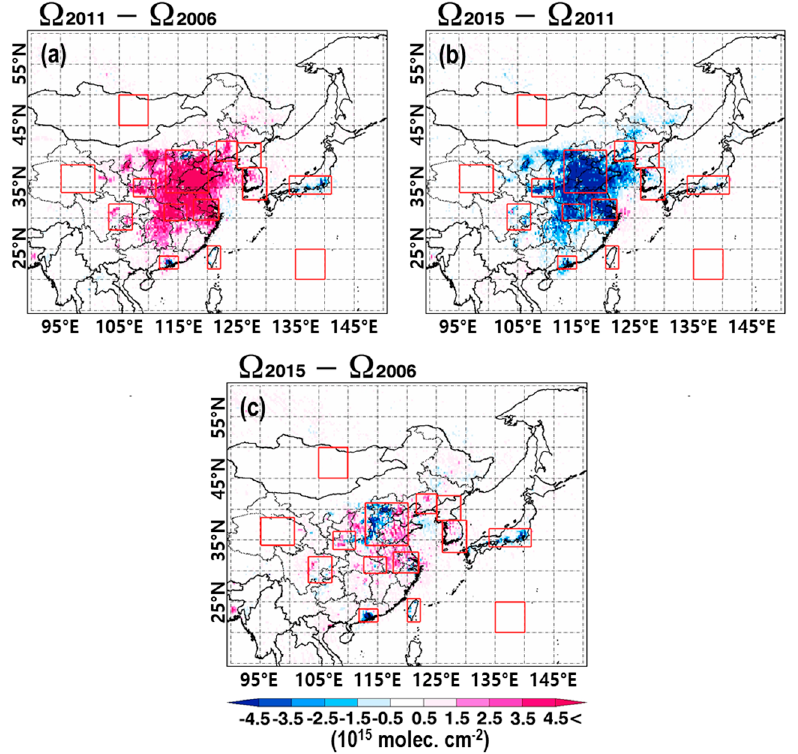
Figure 6. Spatial distributions of NO 2 column di ff erences ( a ) between 2011 and 2006, ( b ) between 2015 and 2011, and ( c ) 2015 and 2006.